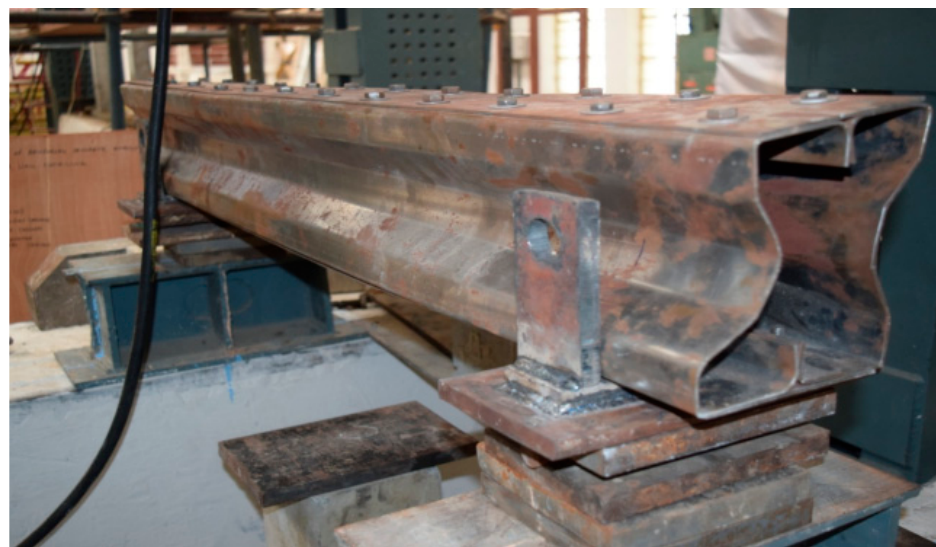
Figure 10. The failure mode of F2F100.